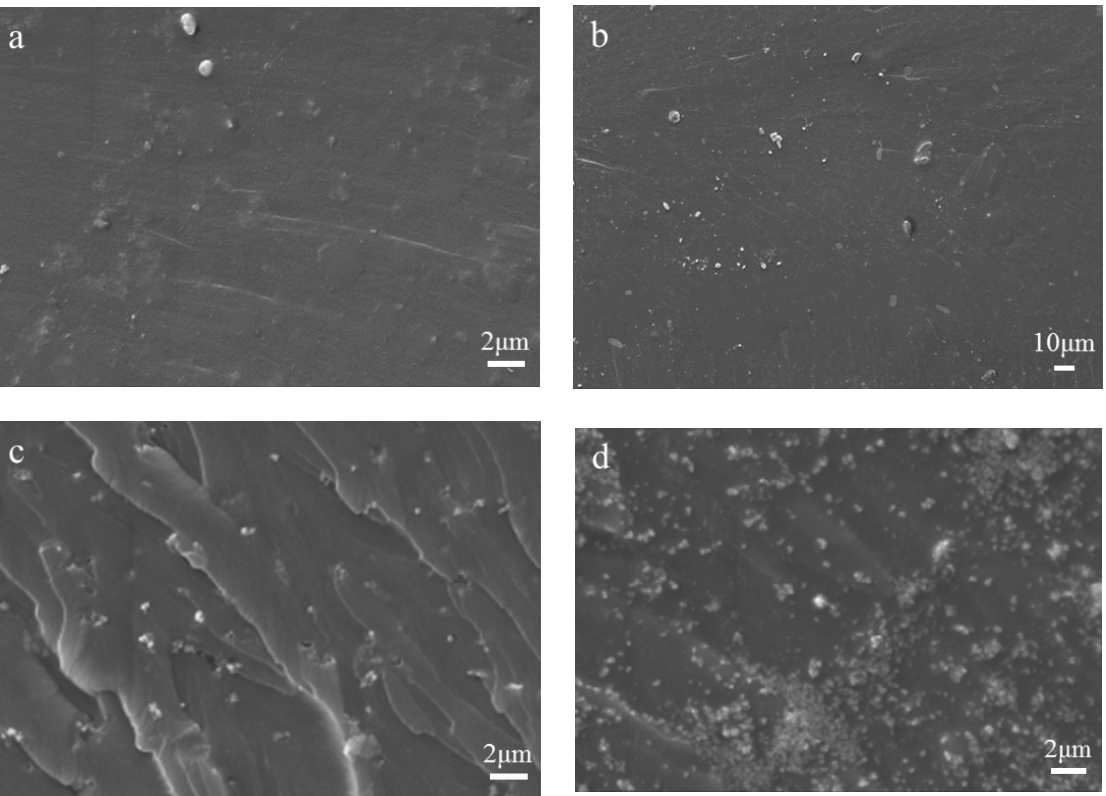
Figure 7. SEM images of quenched sections of silver-loaded TiO 2 light-cured coatings with different additives: ( a ) 1% Ag-TiO 2 ; ( b ) 2% Ag-TiO 2 ; ( c ) 3% Ag-TiO 2 ; ( d ) 5% Ag-TiO 2 .